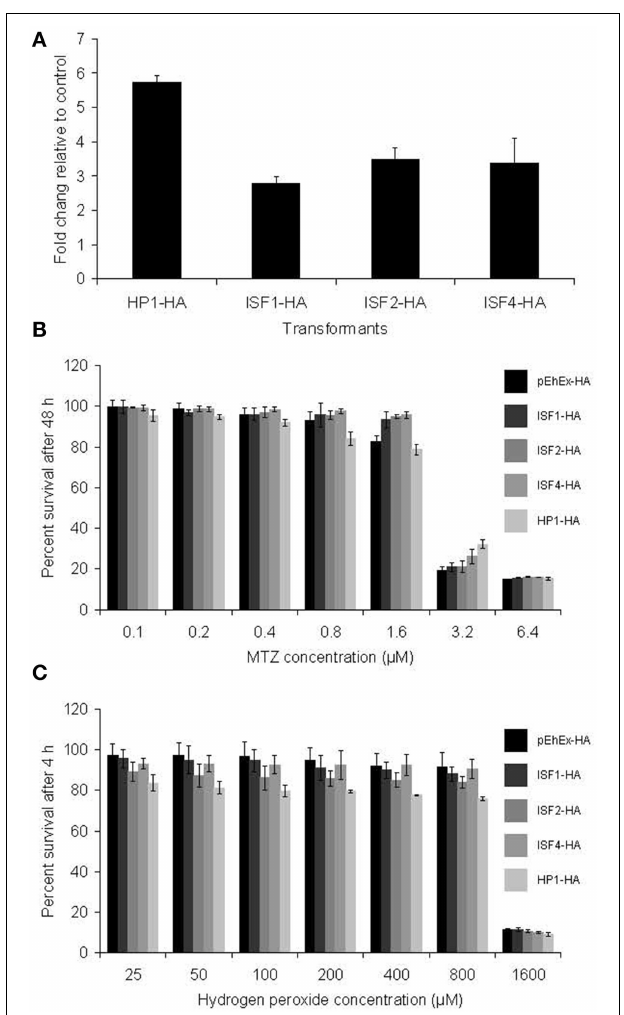
FIGURE 4 | (A) qRT-PCR measurement of transfected genes in HP1-HA, ISF1-HA, ISF2-HA, and ISF4-HA showed overexpression of the genes. Fold changes relative to pEhEx-HA are shown. (B) MTZ challenge of the transformants. Transformants cultured with 10 µ M G418 were challenged with MTZ for 48h. (C) Hydrogen peroxide challenge of the transformants. Indicated transformants were cultured with 25–1600 µ M hydrogen peroxide for 4h.